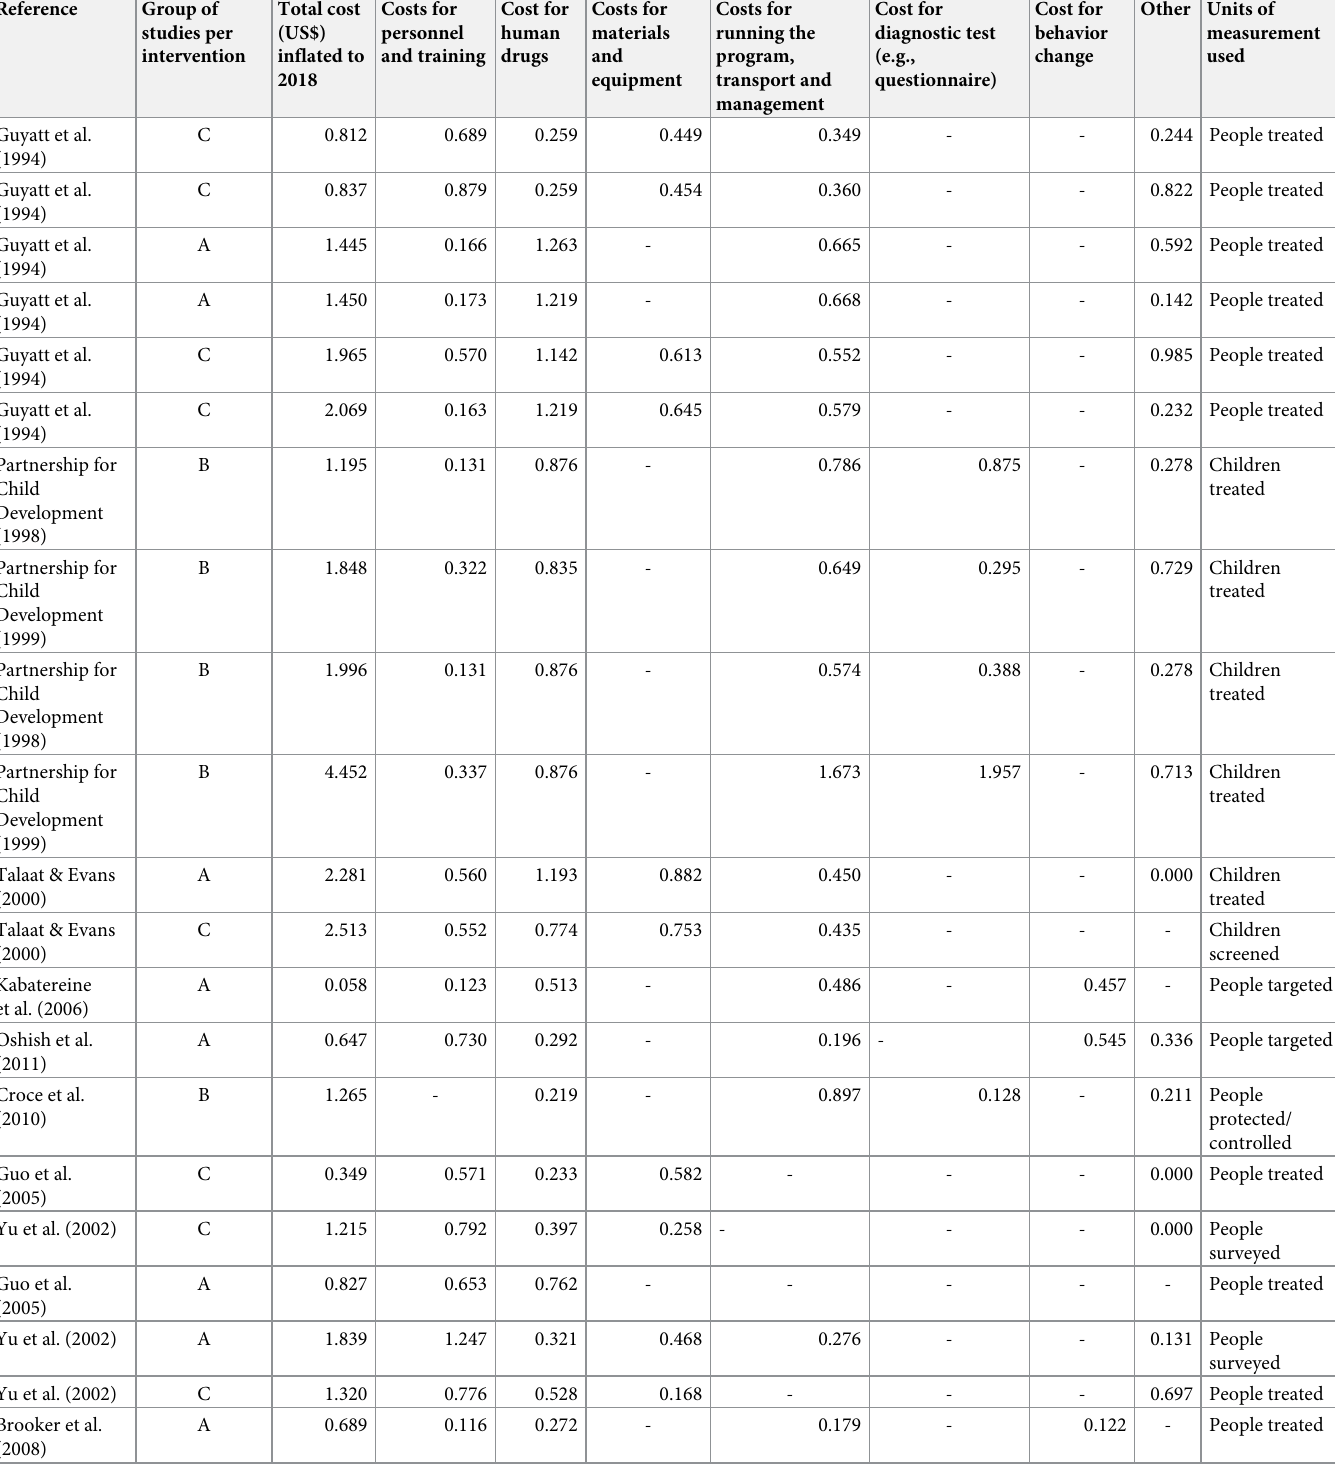
Table 4. List of analyses and their unit costs ordered by year when the intervention occurred.